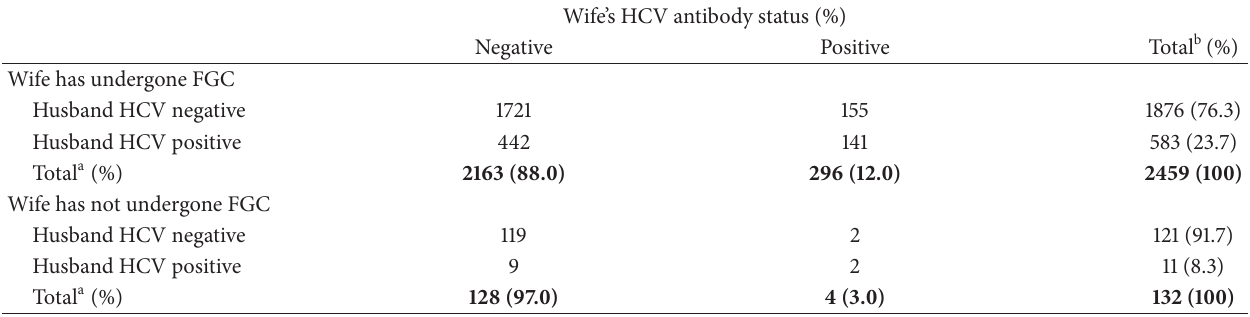
a Row percentages. b Column